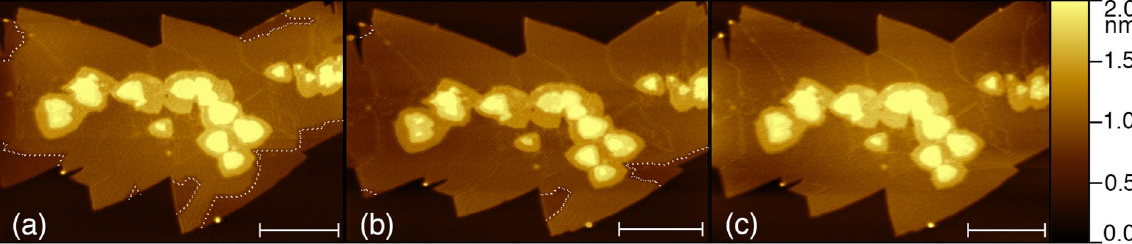
Figure 7. AFM images of MoS 2 at constant tip-sample voltage ( a ) 3 hours after annealing, ( b ) 5 hours after annealing, and, ( c ) 7 hours after annealing. Domains of different contact potential can be observed to slowly contract until the sample reaches a homogeneous state with φ